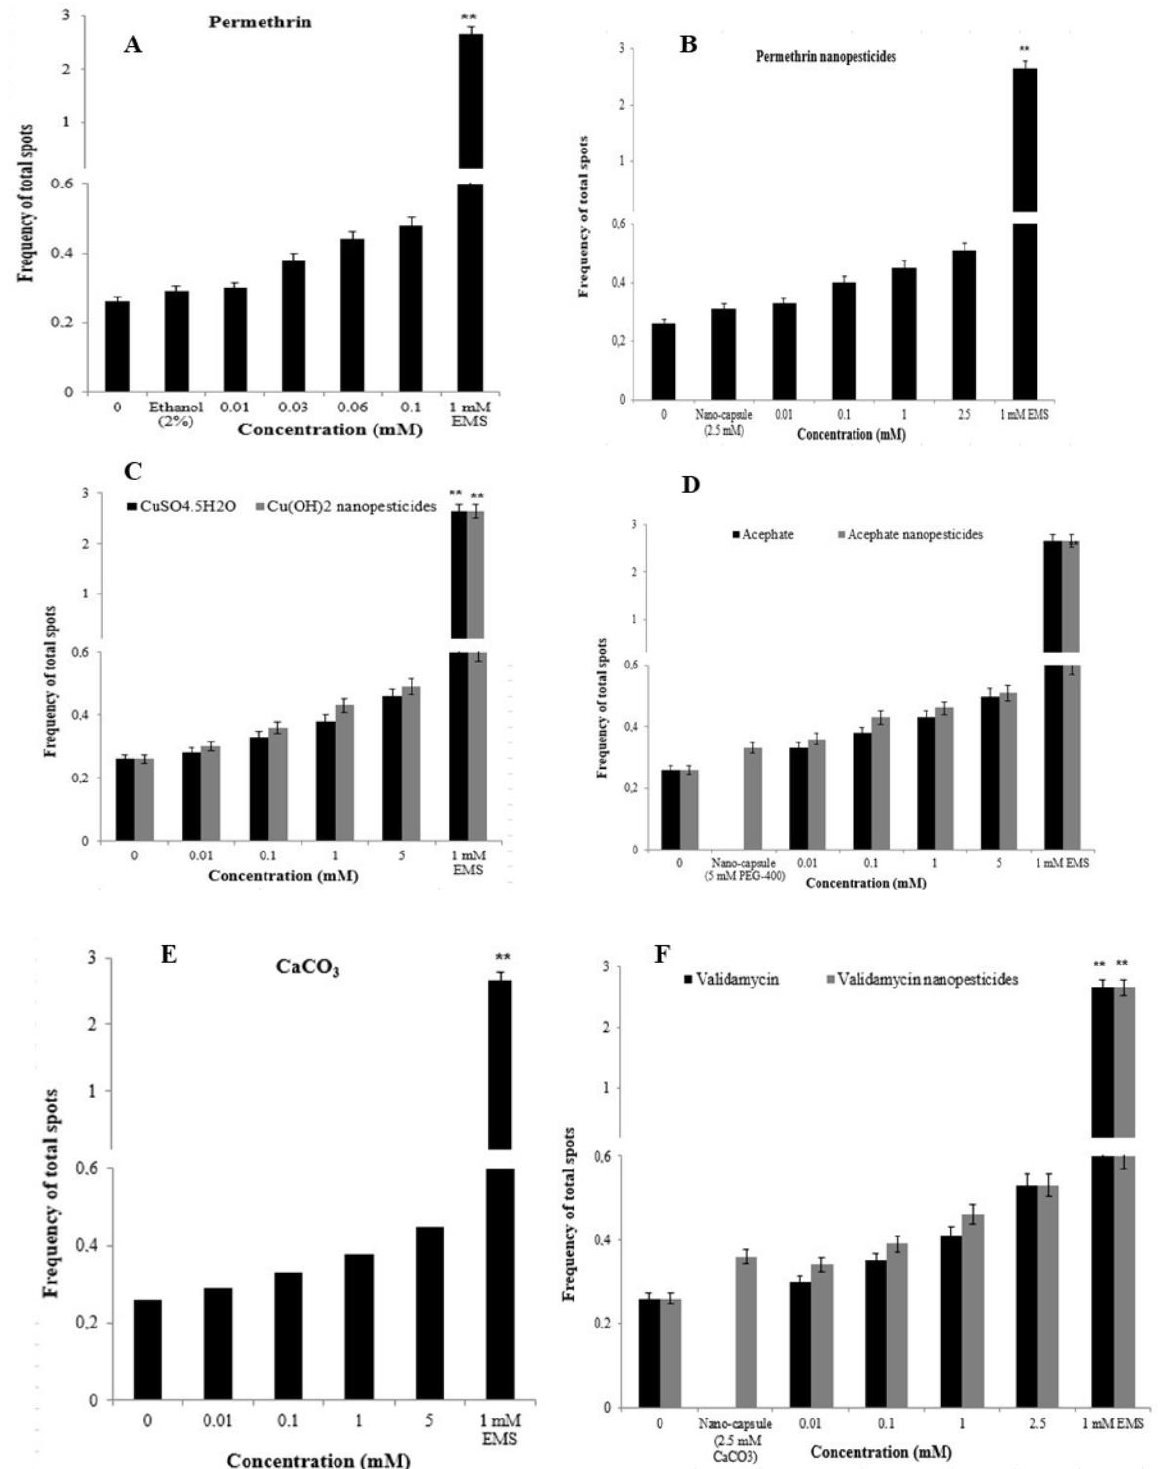
Figure 10. Induction of mutant clones in the wing spot assay: The frequency of total mutant spots per wing induced by permethrin ( A ), permethrin nanopesticides ( B ), CuSO 4 · 5H 2 O and Cu(OH) 2 nanopesticides ( C ), acephate and acephate nanopesticides ( D ), CaCO 3 ( E ), and validamycin and validamycin nanopesticides ( F ) did not differ from the control frequency. As observed, EMS (1 mM) induced a clear increase in the frequency of mutant clones. Data represent the mean ± standard error of the mean; ** p < 0.01 compared with untreated larvae (Mann – Whitney U -test).